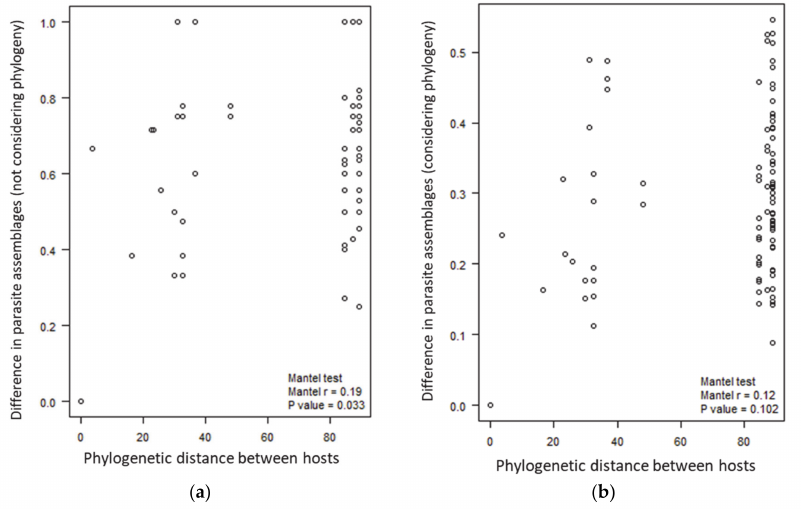
Figure 3. Mantel test between the phylogenetic distance of host species and the difference in the parasite assemblages harbored by each host: ( a ) not considering parasite phylogeny; ( b ) with parasite phylogeny